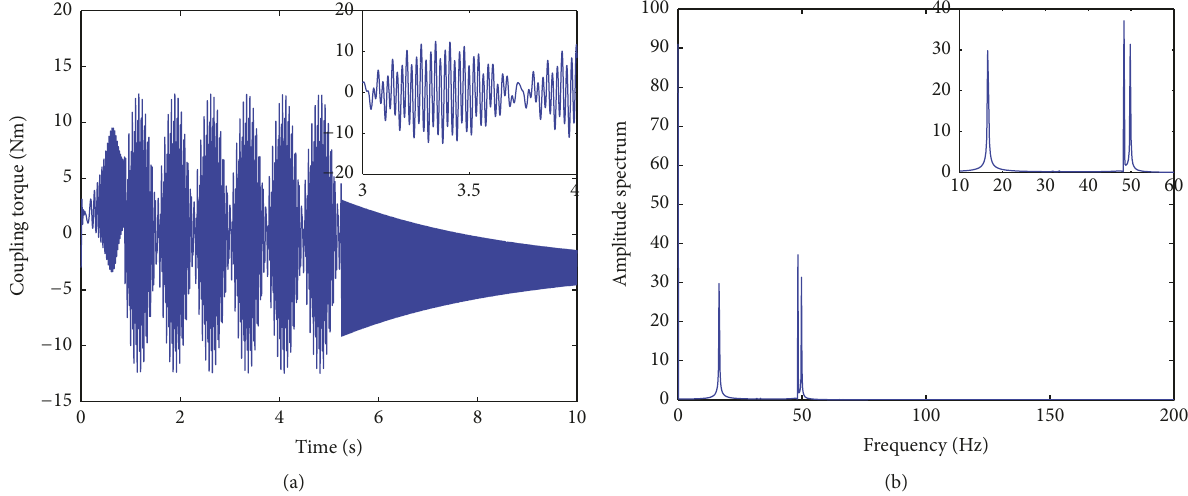
Figure 10: Coupling torque with zoom in the steady state (a) and its FFT with zoom in the peaks (b) for the total